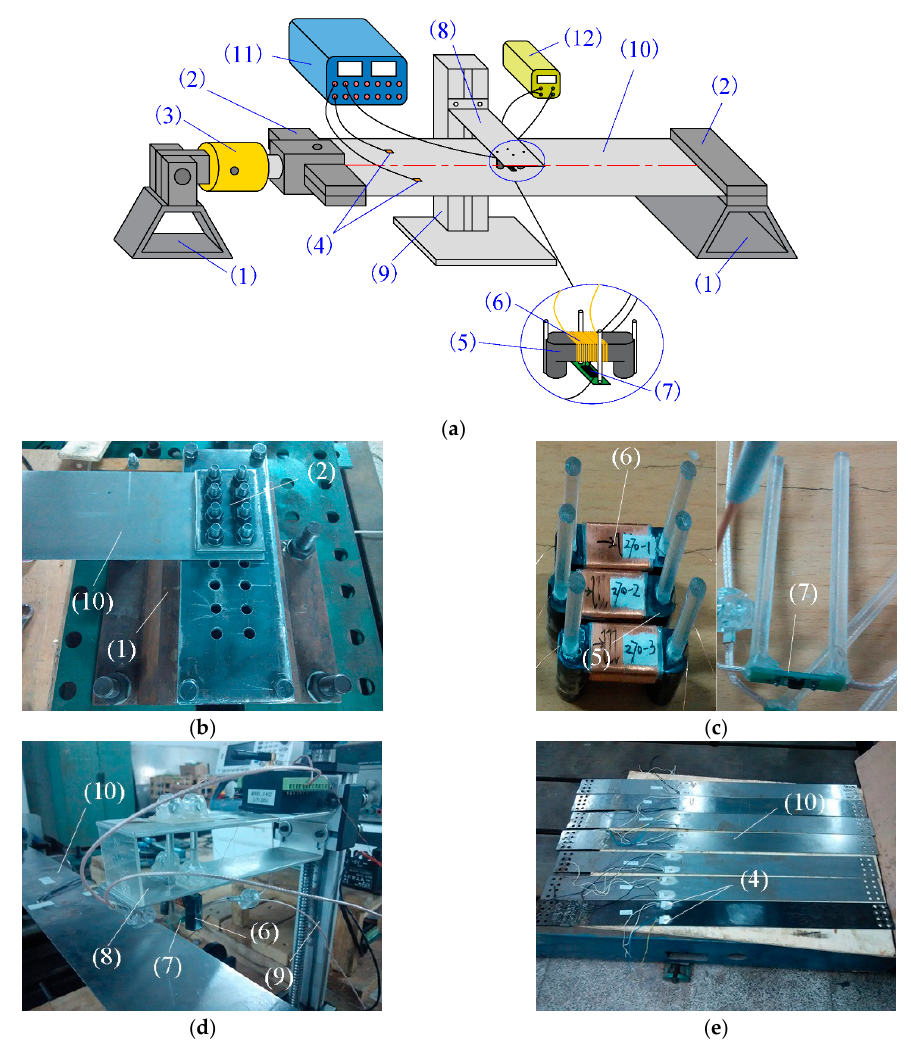
Figure 5. Composition and structure of experimental device for stress detection: ( a ) Structure diagram of experimental device; ( b ) Fixed method of detected strip steel; ( c ) Exciting magnetic core and magneto-resistive sensor; ( d ) Installation method of exciting magnetic core and magneto-resistive sensor; ( e ) Detected strip steel and strain gage. The device components include: (1) supporting frames, (2) clamping plates, (3) hydraulic cylinder, (4) strain gauges, (5) magnetic core, (6) excitation coil, (7) magneto-resistive sensor, (8) supporting plate, (9) guide rail, (10) strip steel, (11) data acquisition instrument, and (12) power supply.